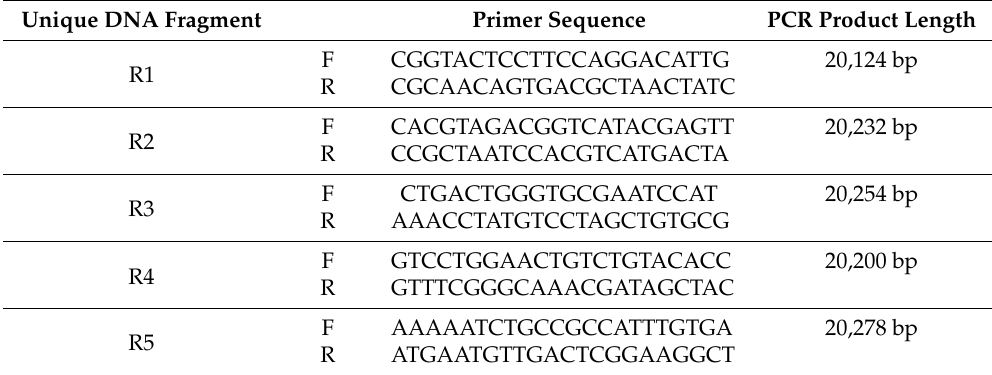
Table 1. Primers used for the amplification of unique DNA